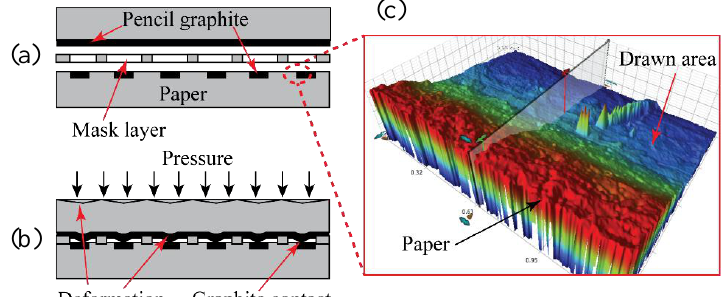
Figure 1. ( a ) Concept sketch of sensing mechanism with no applied pressure, ( b ) concept sketch of the sensing mechanism with applied pressure, and ( c ) 3D surface profile of GoP devices.